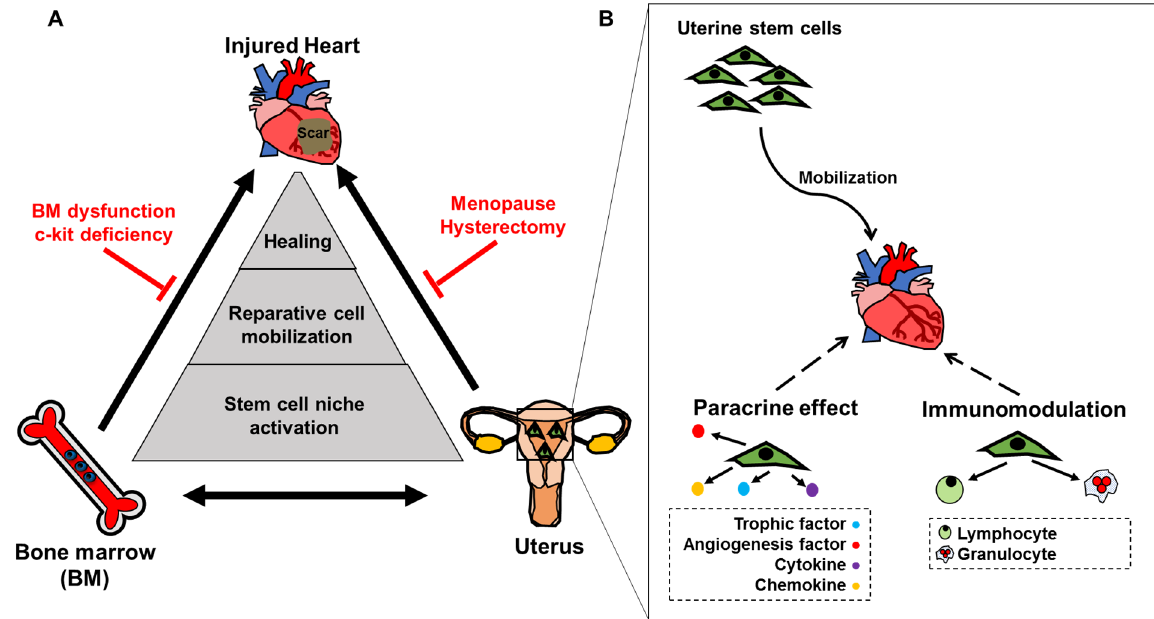
Figure 1. Relationship among the heart, uterus and bone marrow. ( A ) Schematic of the triangular relationship among heart, bone marrow, and uterus; the uterus is able to reciprocally interact with the BM to serve as a second stem cell reservoir. Cardiac injury triggers activation of both bone marrow and uterine stem cell niches, leading to mobilization of reparative cells from both niches, which traffic to the injury site to promote healing. ( B ) The utero-cardiac cross talk involves uterine stem cell mobilization to exert paracrine and immunomodulatory